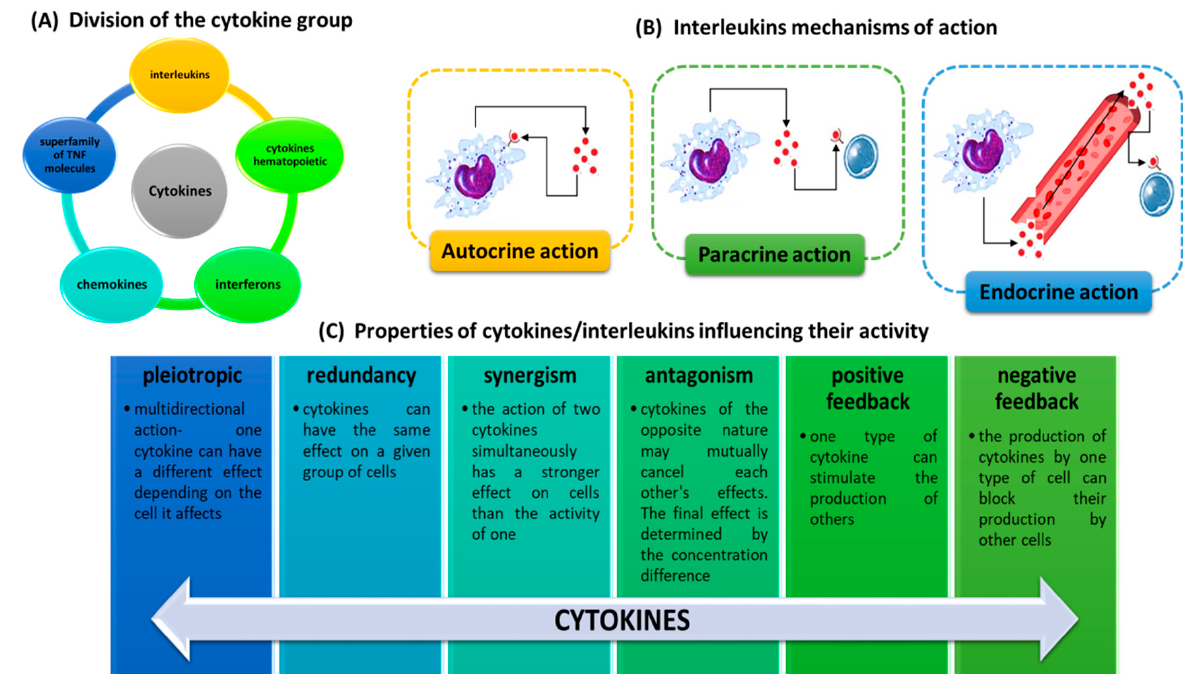
Figure 1. Characterization of interleukins. ( A ) Division of the cytokine group. ( B ) Mechanisms of action of interleukins. ( C ) Properties of interleukins influencing their activity (based on [5,31–34]).